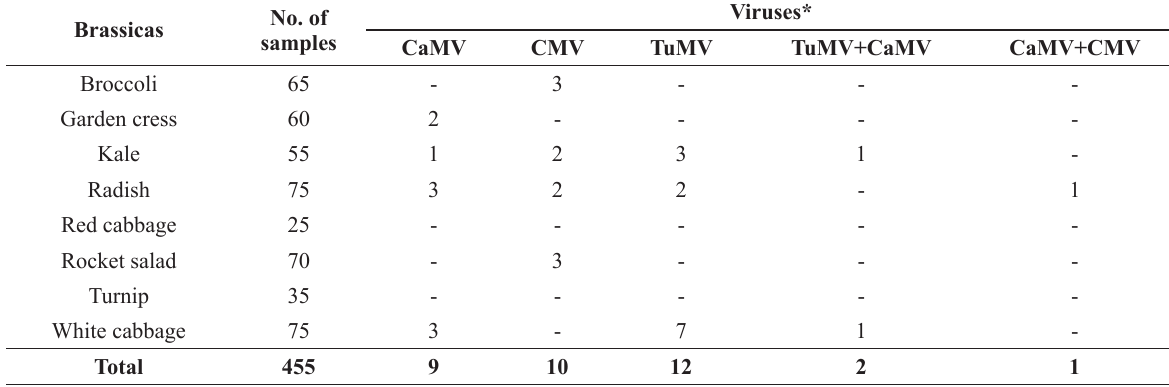
Occurrence of viruses infecting field-grown species of the Brassicaceae family. No. of Brassicas